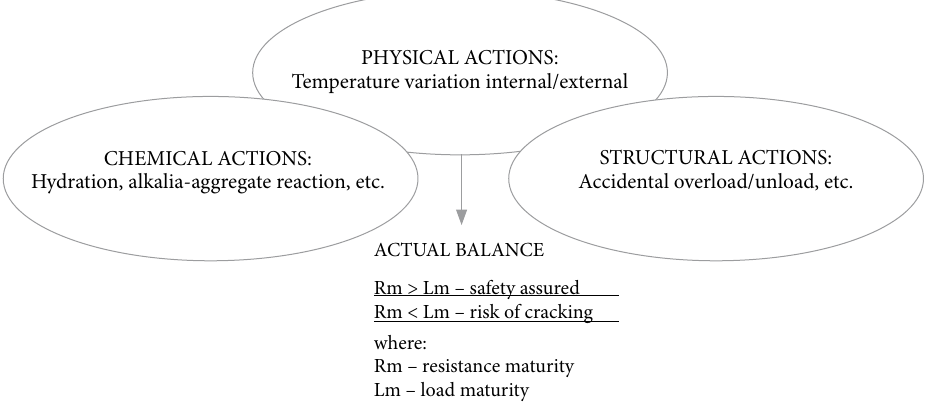
Fig. 2. General idea of resistance and load balancing in concrete maturing